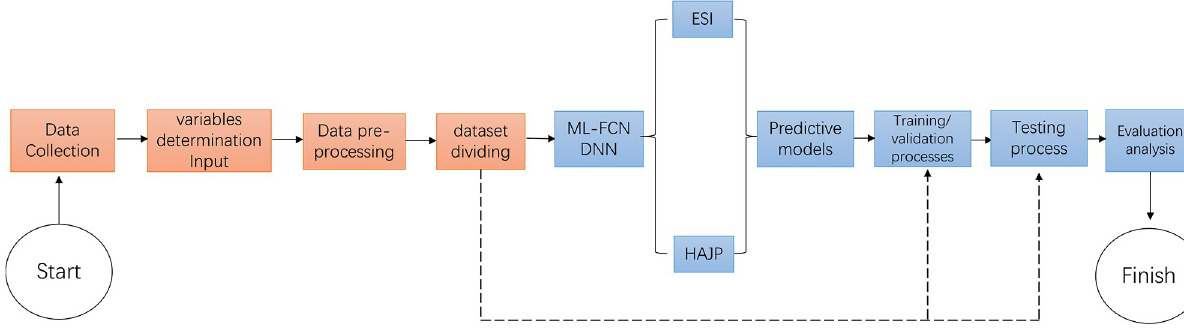
Fig 3. The procedure of constructing a predictive